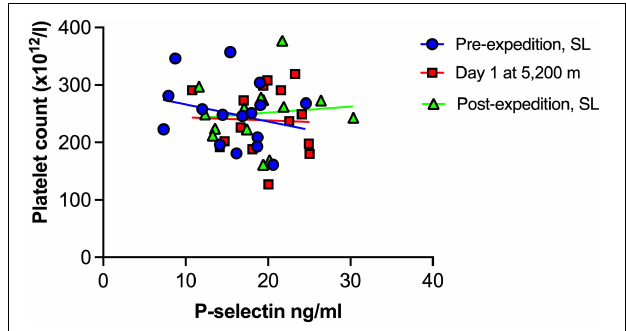
FIGURE 4 | No association between Plasma P-selectin and platelet count at sea level or during high altitude induced hypoxia. Plasma P-selection assessed by Luminex immunoassay ( n = 16). SL, sea